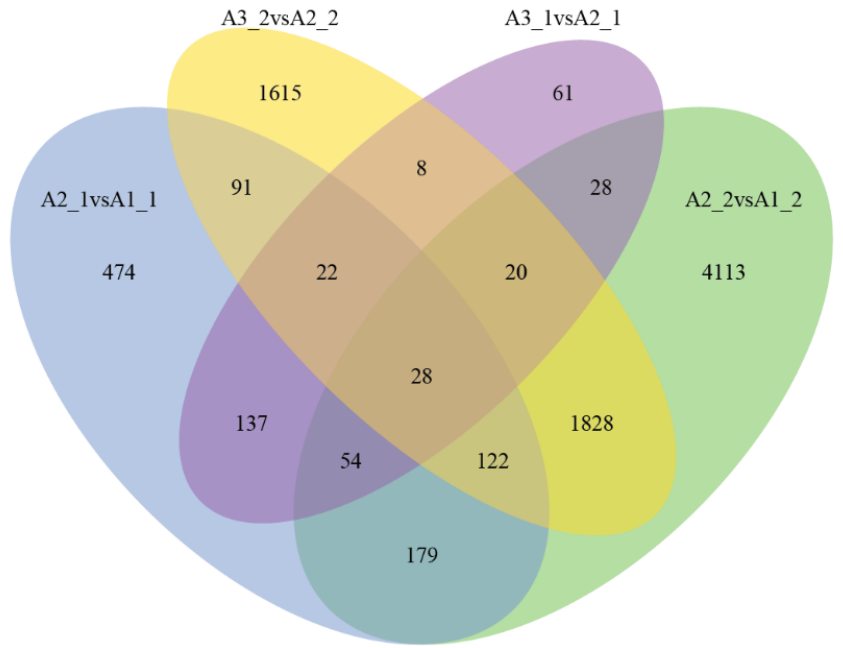
Figure 4. “A2_1 vs. A1_1” indicates the comparison of gene expression in the A2_1 library with that in the A1_1 library, and three other comparisons are indicated.